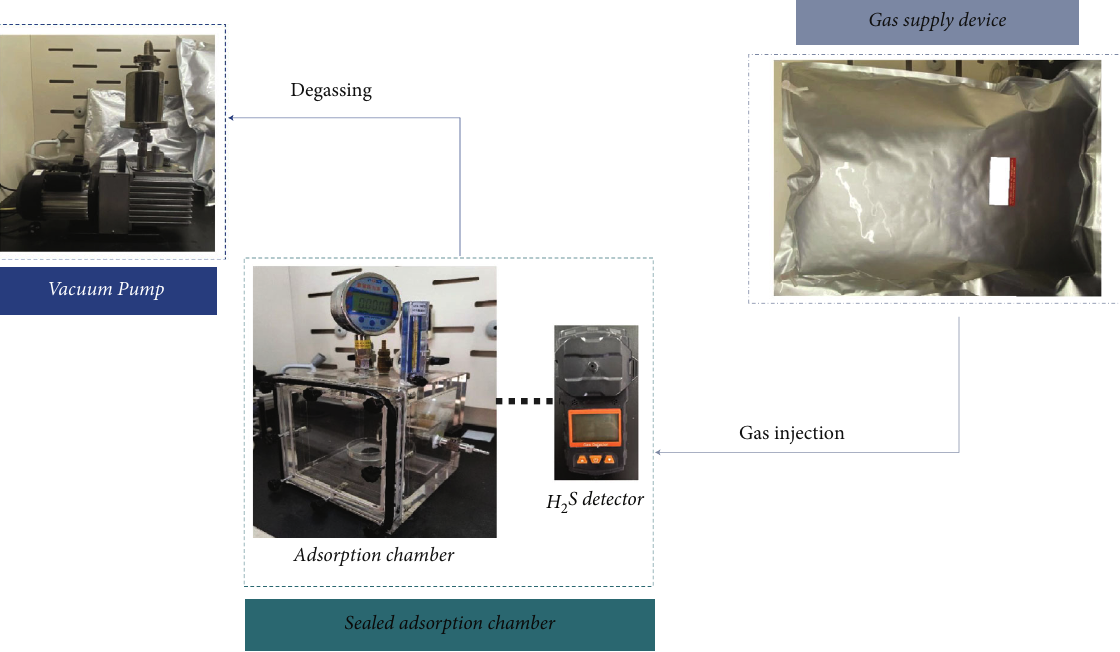
Figure 2: Experimental system for H S adsorption in coal at the atmosphere temperature and pressure (Vacuum Pump, Adsorption 2 S detector, and H S collection bag photograph courtesy of Zhe Jia, Copyright chamber, H 2 2